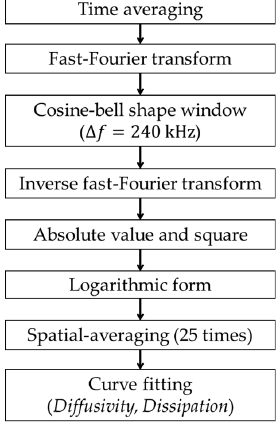
Figure 6. Flow chart of data processing.